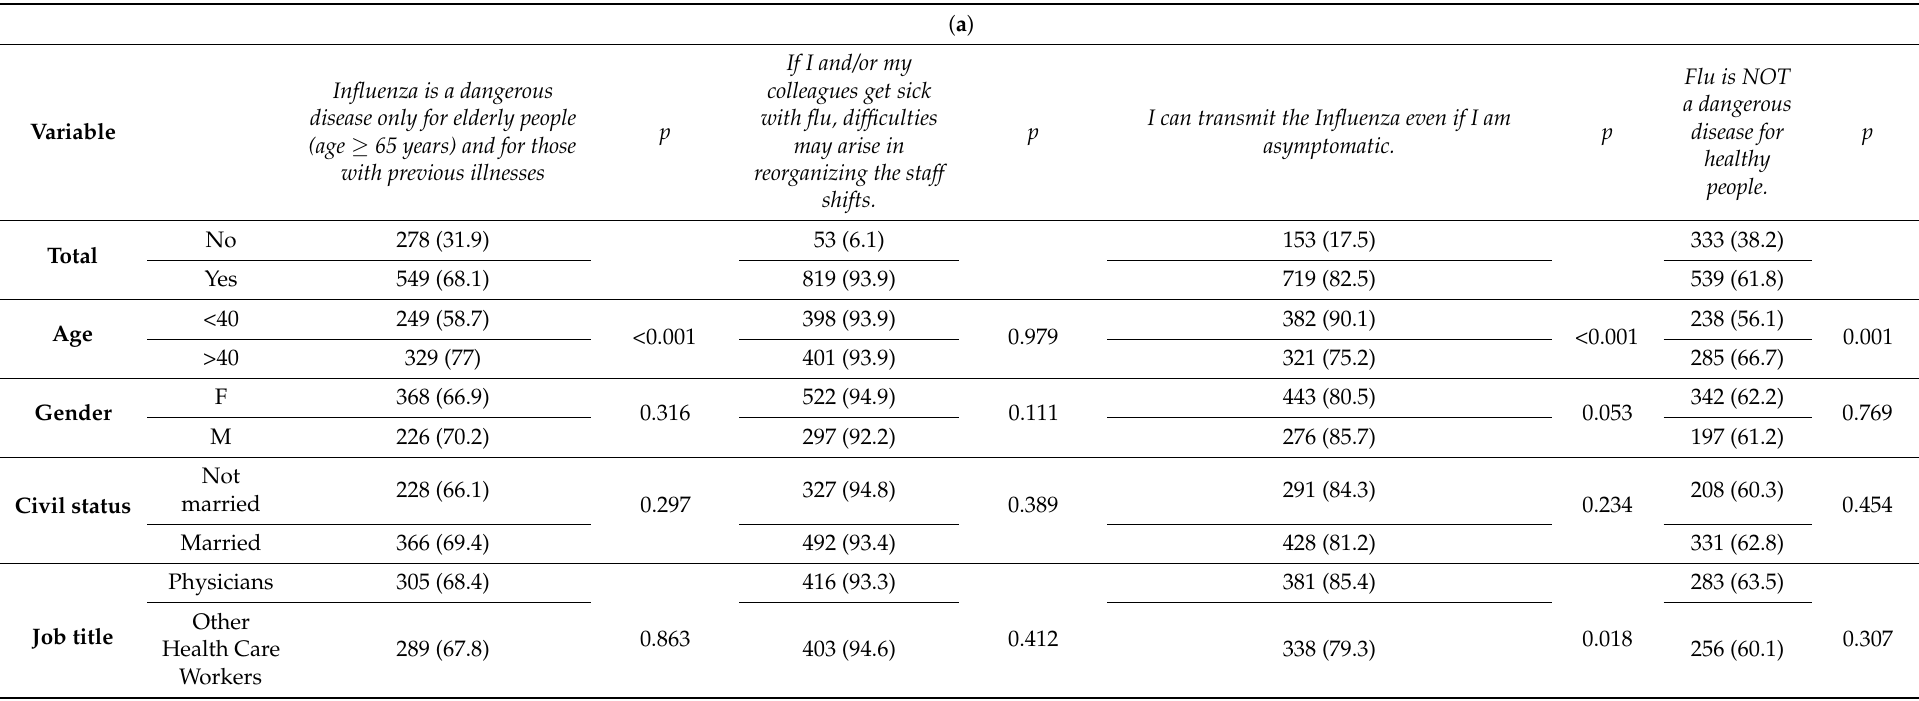
Table 2. ( a ) Univariate analysis—what do HCWs think about influenza? Absolute values and percentages of the Yes answers are reported. ( b ) Univariate analysis—vaccine obligation. Absolute values and percentages of the Yes answers are reported. ( c ) Univariate analysis—promotion and vaccine hesitancy. Absolute values and percentages of the Yes answers are